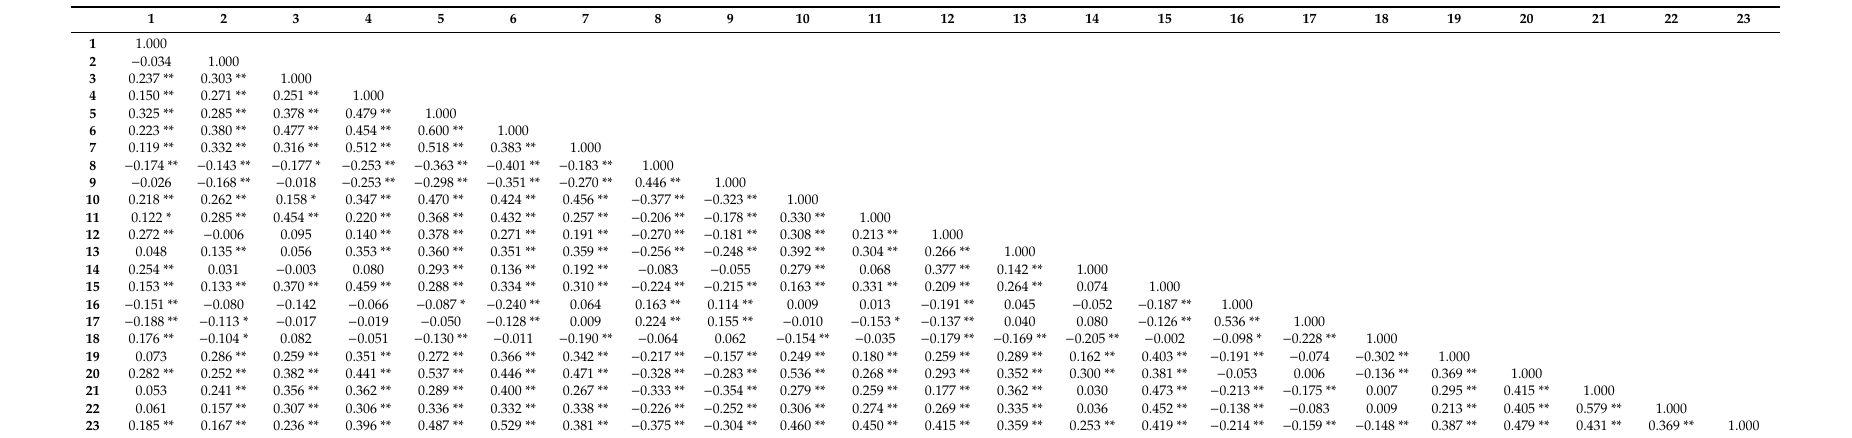
Table A2. Correlations between the items of the UWPQ (Spearman’s